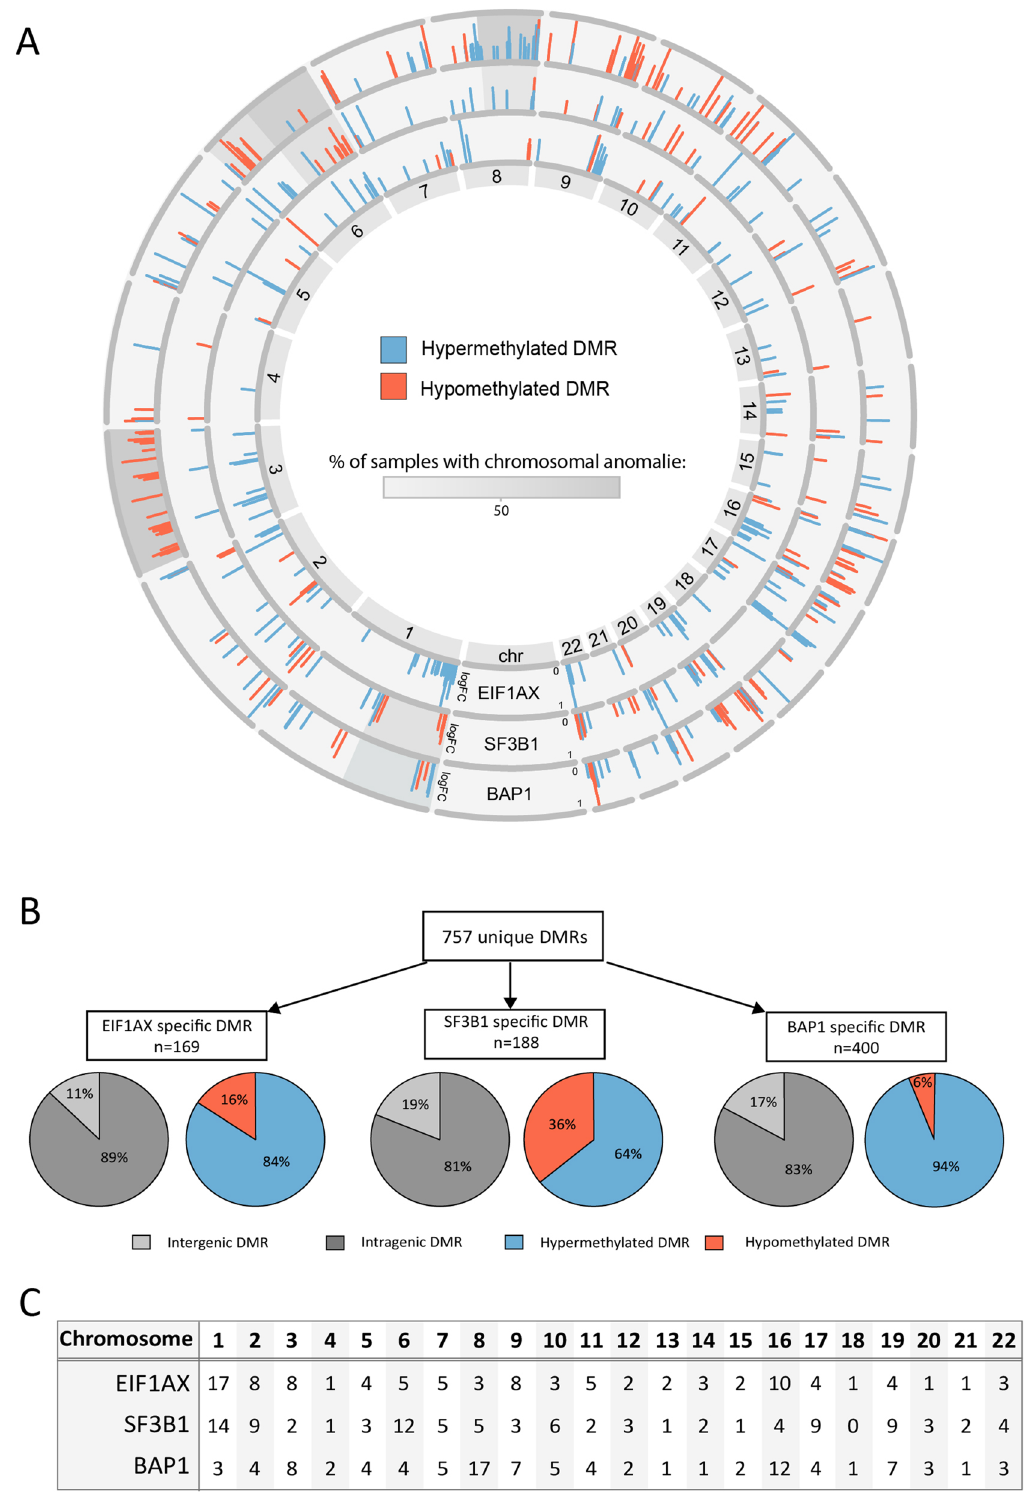
Figure 1. (A ) All differentially methylated regions (DMR) visualized per chromosome in a donut plot. The height of the bar indicates the log Fold Change (0–1). Chromosomal anomalies are indicated by the grey scale. The outer ring shows the BAP1 unique DMRs, the middle ring the SF3B1 unique DMRs and the inner ring the EIF1AX unique DMRs. ( B) Quantification of all unique DMRs per group. The genomic location of each DMR is indicated by the grey pie chart, where light grey indicates an intergenic location and dark grey indicates an intragenic location. The amount of methylation of each DMR is shown by the red (hypomethylation) or blue (hypermethylation) pie chart. ( C) The percentage of DMRs per chromosome is shown for each individual